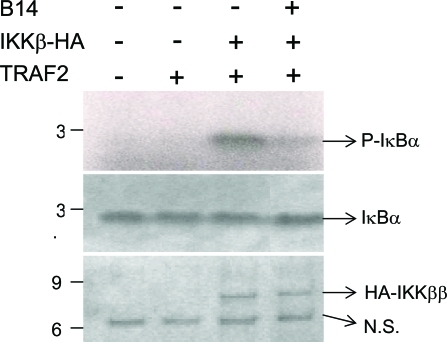
B14 Inhibits IKK-Mediated Phosphorylation of IκBαHEK 293 cells were transfected with plasmids expressing the indicated proteins (2 μg of vectors expressing B14, TRAF2, and HA-IKKβ). The empty vector pCI was used to adjust the total DNA added to 6 μg per reaction per 10 cm dish. After 24 h, 1.5 mg of cell extracts were immunoprecipitated with anti-HA mAb for 3 h at 4 °C. The immune complex was incubated with 5 μg of IκBα peptide and 5 μCi 32PγATP for 10 min at 30 °C. The kinase assay was terminated by adding protein loading buffer and the mixture was resolved and analysed by Coomassie staining followed by autoradiography (top panel, kinase assay). Protein markers (kDa) were indicated on the left. N.S. indicates non-specific band.